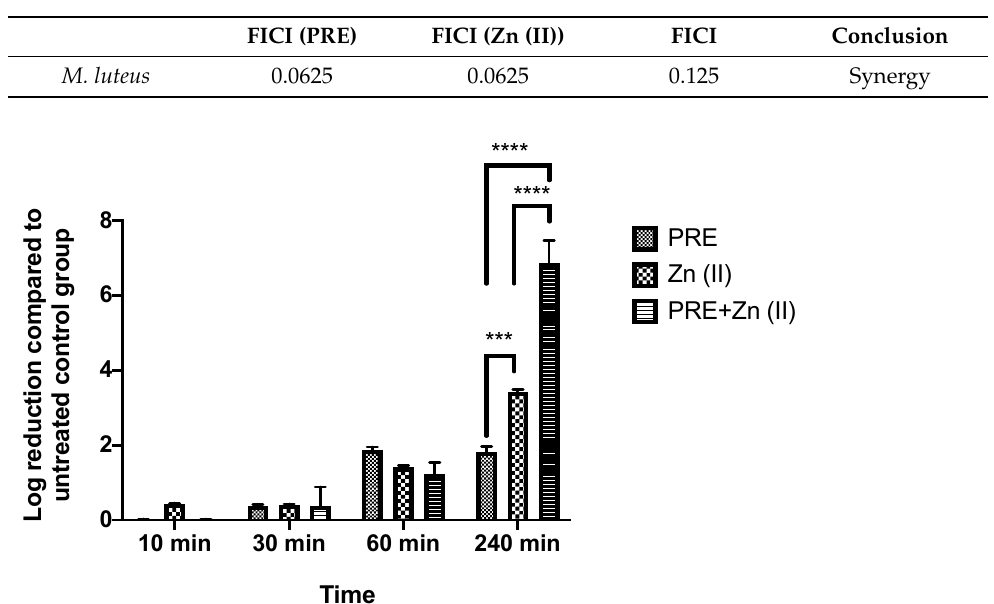
Table 2. FICindex values determined for PRE and Zn (II) alone and in combination using an in vitro checkerboard assay against M. luteus .